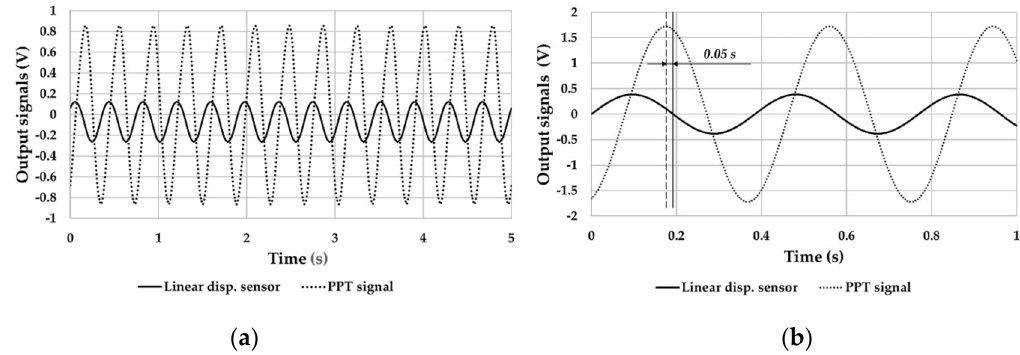
Figure 13. ( a ) Harvester and linear displacement sensor signals over time and ( b ) sinusoidal laws of outputs from PPT and displacement sensor.